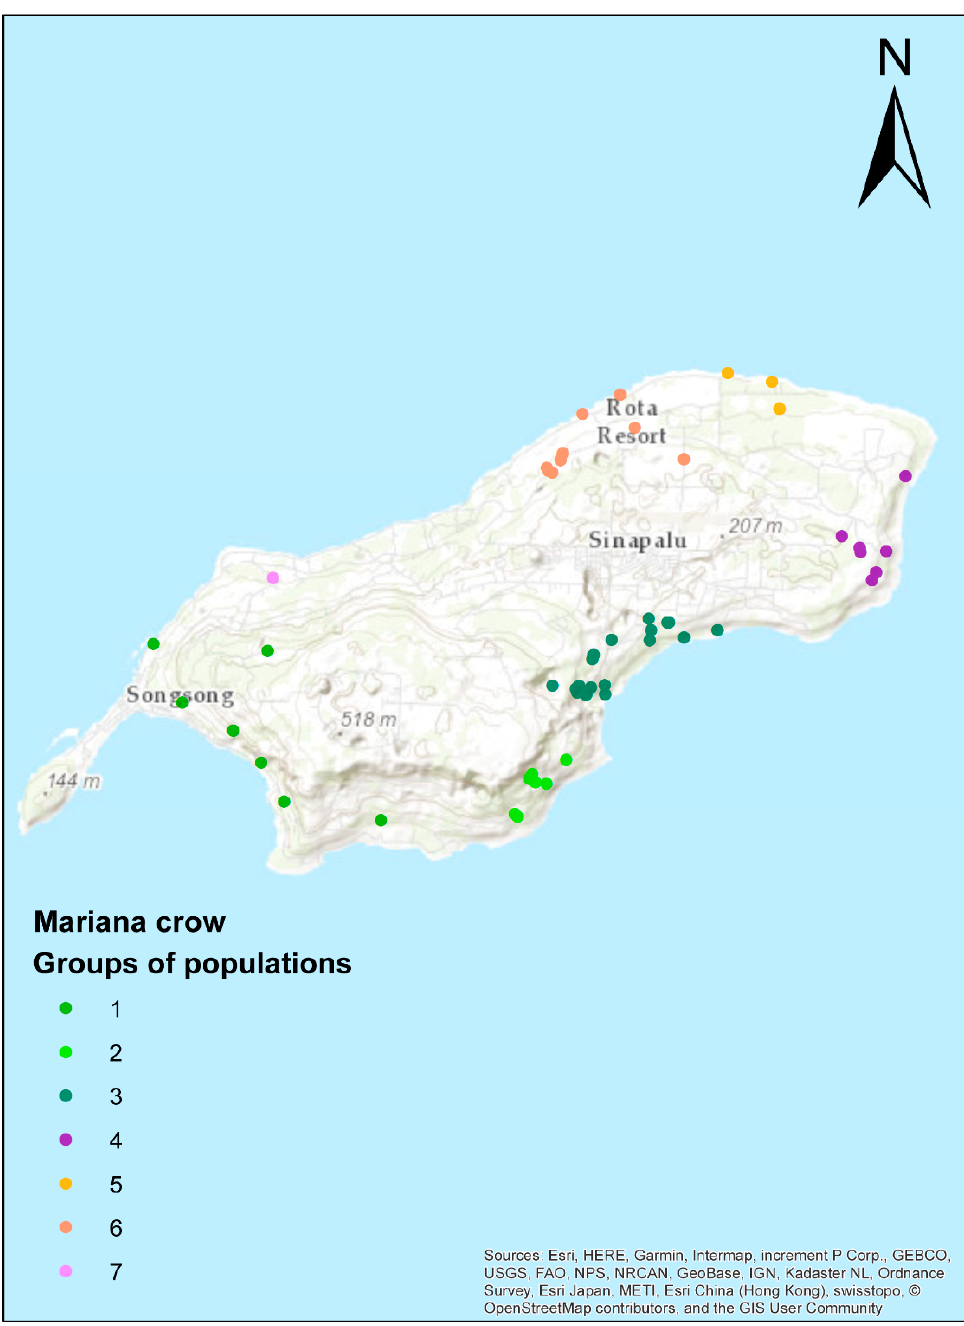
Figure 3. Assignment of Rota crows to populations based on their known provenances. Each dot represents a single individual and is colored by its population assignment.